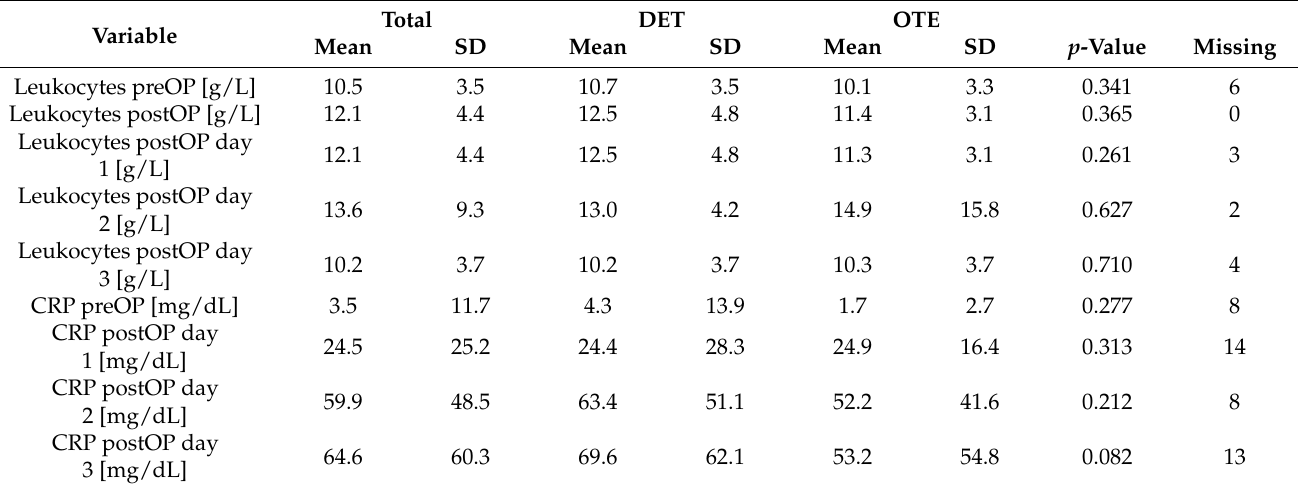
Table 1. Perioperative markers of